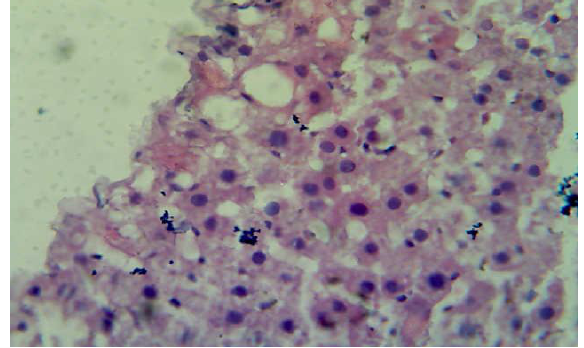
Figure, 9. In section of histopathology in the liver of rat receiving 1mg/kg B.W of acrylamide for 65 days (G3 group): showed fatty changes (H.& E.stain 400X).